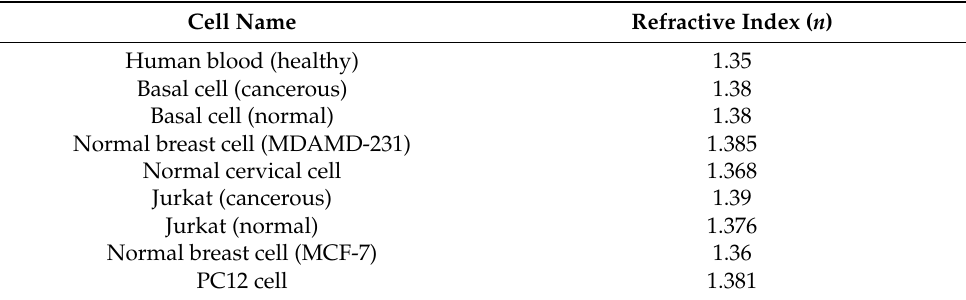
Table 4. Refractive indices for various cells in their normal and cancerous states